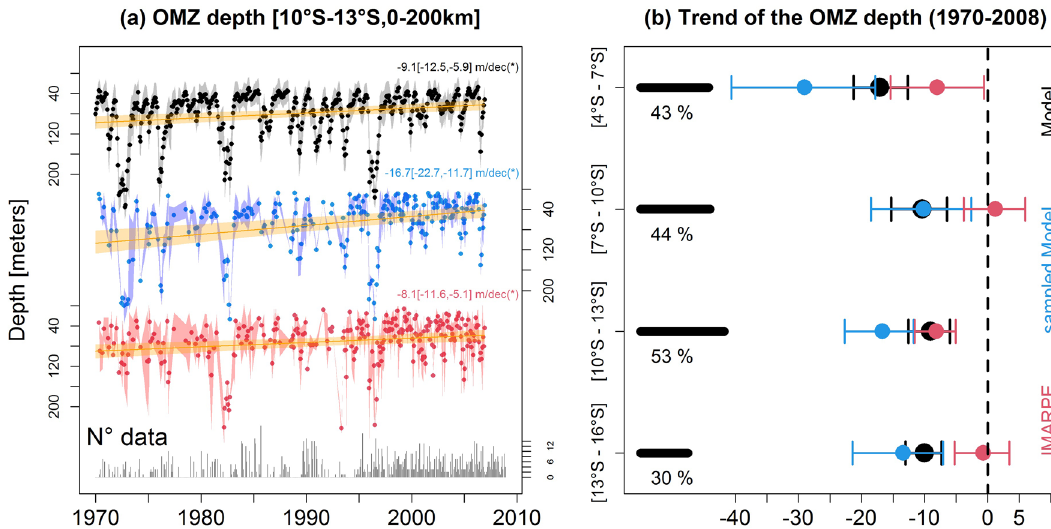
Figure 2. Oxycline trends along the Peruvian coasts. ( a ) Oxycline depth (in meters) over 1970–2008, averaged in a coastal box (10–13° S, from the coast to 200 km offshore) from IMARPE observations (red), model (black) and model output subsampled in the same way as the observations (blue). The number of observations per month is indicated at the bottom of the figure. Linear trend values are marked by orange line. Trend values and confidence interval are indicated on the right of the figure. Asterisk denotes a statistically significant trend. ( b ) Oxycline depth trend for different coastal bands: 4–7° S, 7–10° S, 10–13° S, 13–16° S, from IMARPE observations (red dots), model (black dots) and subsampled model (blue dots). The dashed vertical line delimits negative trends. The percentage of months with observations is indicated on the left side of ( b ). Error bars (horizontal segments) are computed using a bootstrap method. The figures were generated using the software R (R Core Team, version 4.1.1., http:// www.R- proje ct. org/).